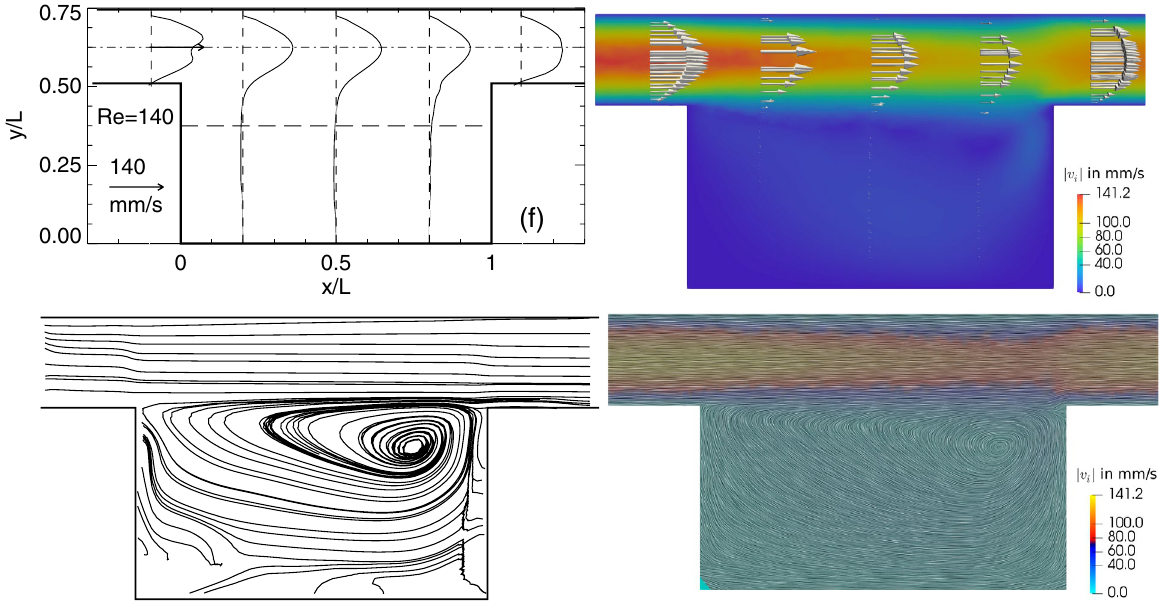
Fig. 11 Comparison of measurement and calculations: Case (f) PIV left column and CFD right column. Selected velocity profiles (top row) and streamlines (bottom row) are presented